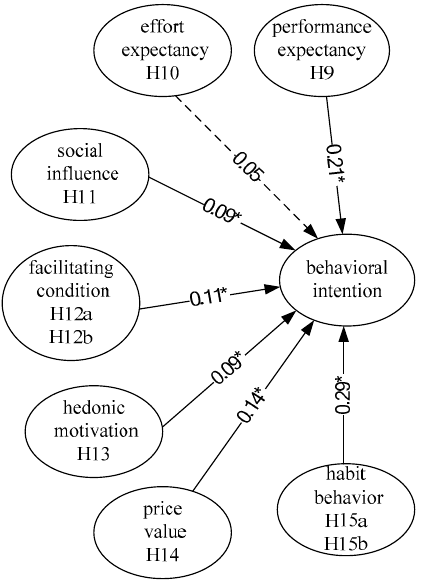
Figure 4. Seven independent variables effect on behavioral intention . * p < 0.05.